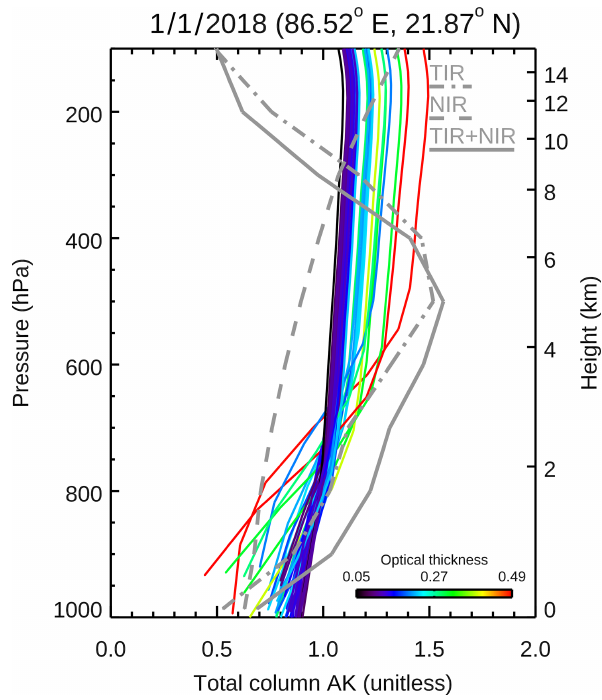
Figure 1. Total column AKs (averaging kernels) from MOPITT and TROPOMI observations acquired 1 January 2018. Gray lines show AKs from a single clear MOPITT pixel. Color-coded lines show AKs from TROPOMI observations colocated with the MO- PITT pixel (same-day acquisition, ≤ 50km horizontal distance) with optical depth < 0 . 5 and cloud height < 5000m (i.e., clear- sky, clear-sky-like, and mid-level cloud observations). Differences in TROPOMI AK vertical extent are due to